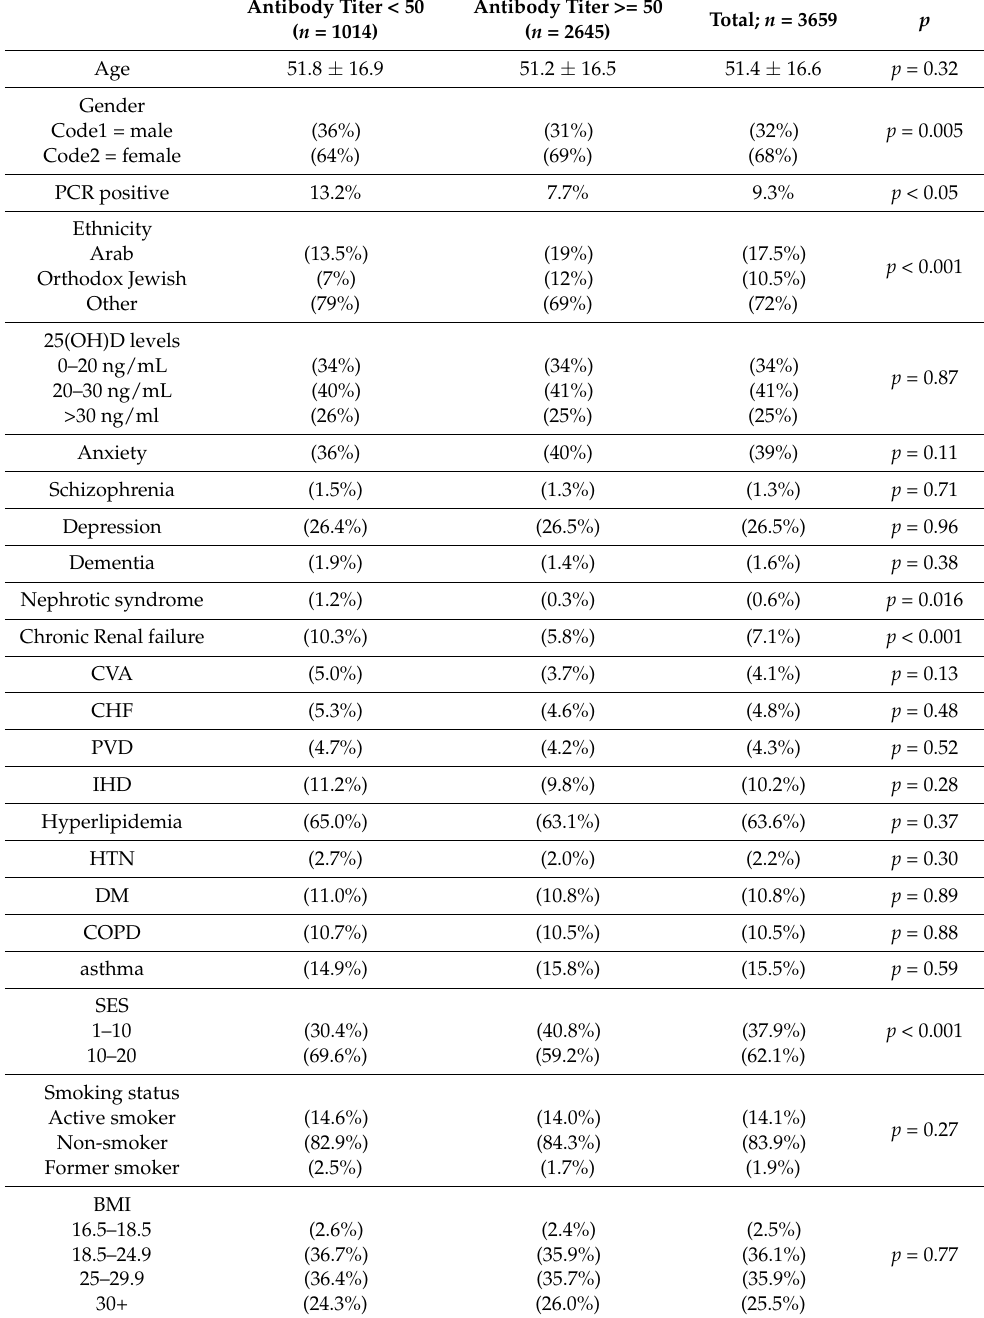
Table 3. Baseline characteristics of the SARS-CoV-2 antibody tests of available, vaccinated participants according to < or >50 AU/mL values. The 3rd column includes the total number of antibody tests